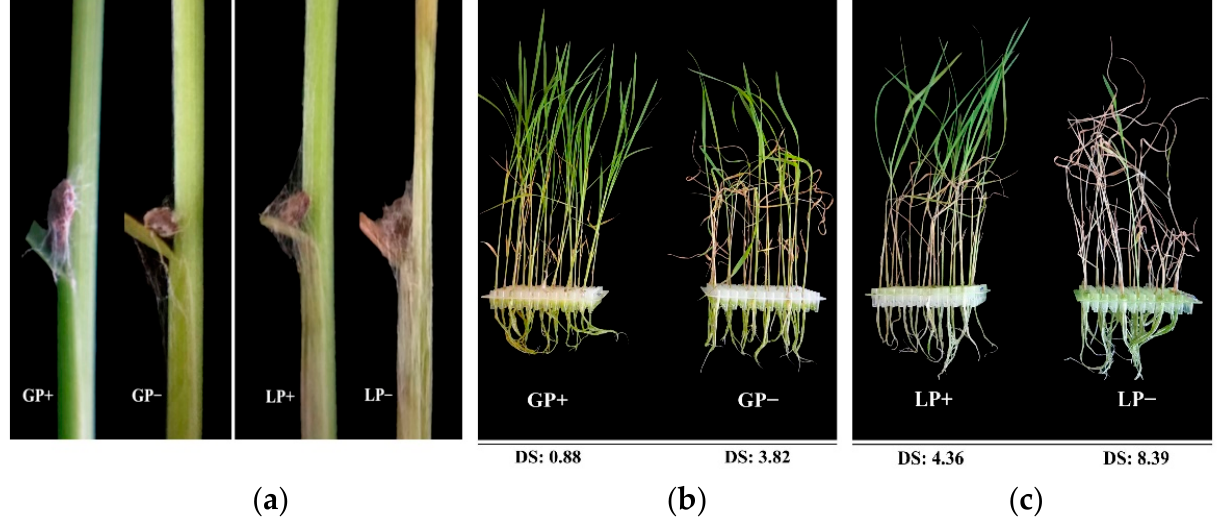
Figure 1. Phenotype of rice treated by different treatments at 96 ( a ) and 144 ( b ), ( c ) hours after inoculation with ShB sclerotia. GP+, GP − , LP+ and LP − indicate PQQ and ddH 2 O treatments in the G and L variety, respectively. DS indicates disease score.